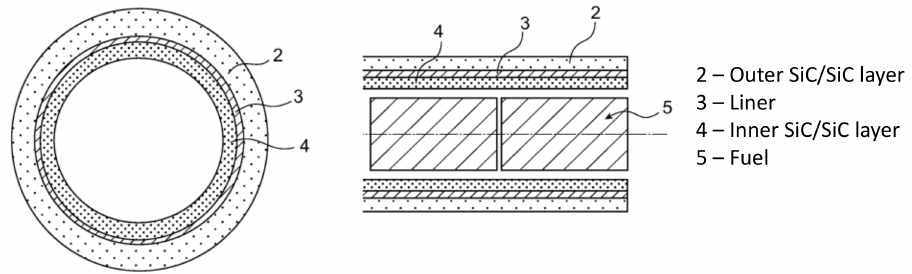
Figure 1. Scheme of sandwich concept [11].